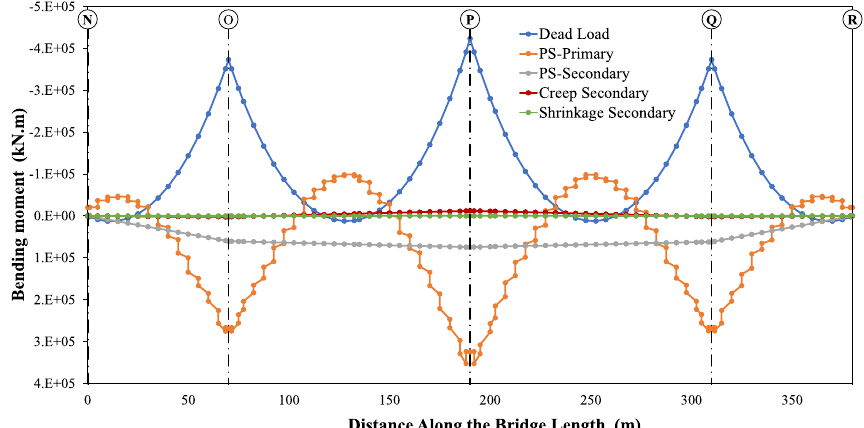
Fig. 6 Itemized bending moments along El Warrak Bridge length from various permanent loads at age of 10,000